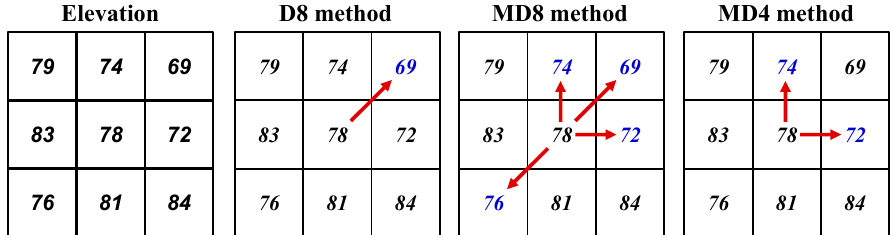
Figure 2. Comparison of different methods of flow-direction determination.